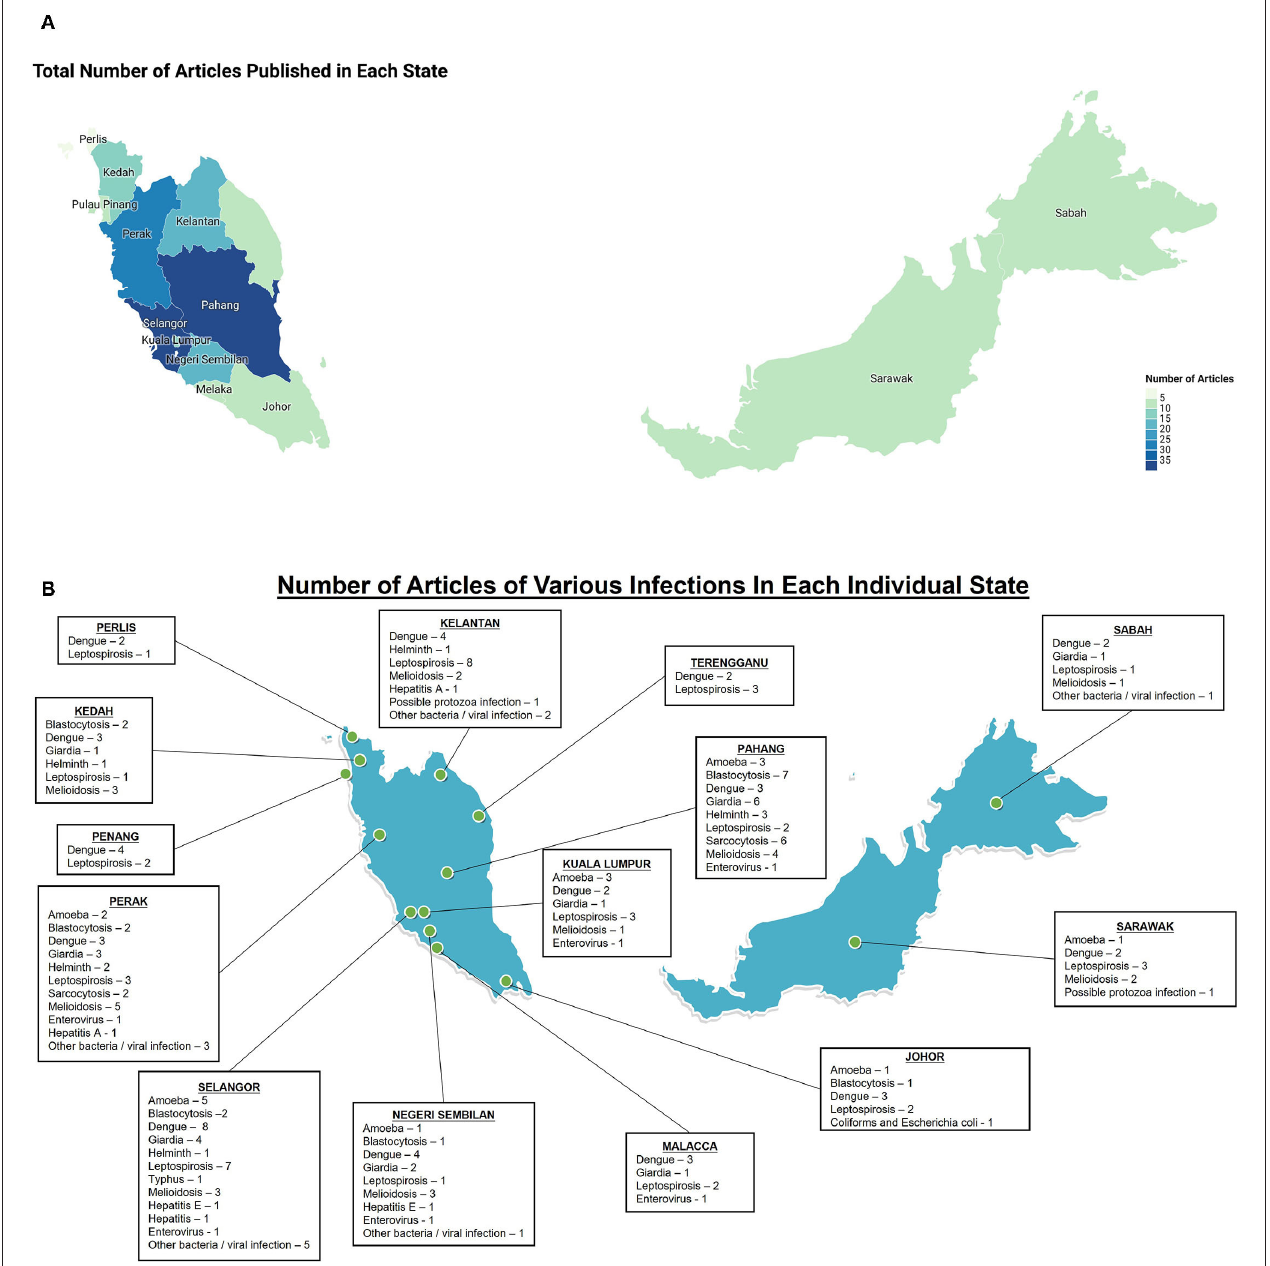
FIGURE 2 | Elucidation of number of articles included in this review in Malaysia, mainly focus on infectious diseases related to human, however if the disease is related to zoonosis, studies on reservoir animals may be included. (A) Total number of articles that were included in each state, the color intensities are proportional to the number of articles; (B) Number of articles for each disease that were included in each